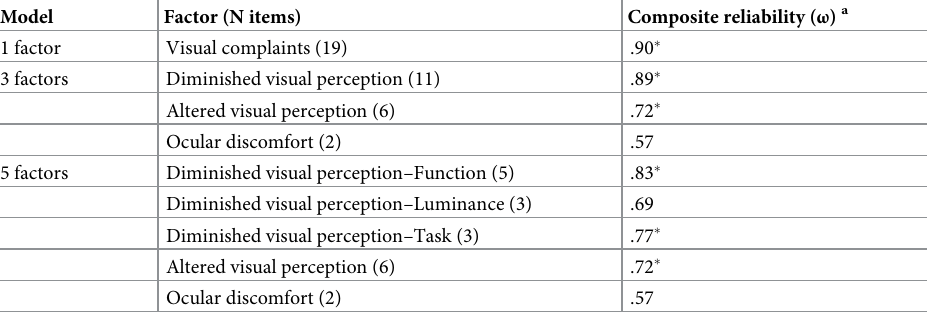
Table 4. Composite reliability of each factor within the three models.